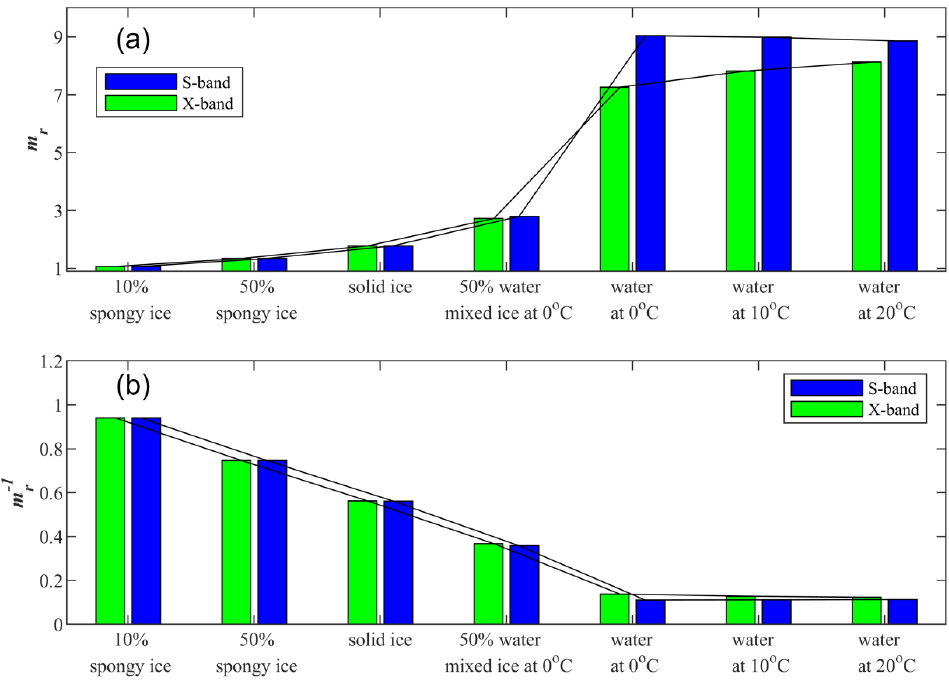
Figure 1. Dielectric property parameters: ( a ) m r and ( b ) m r − 1 of hydrometeors at different phases and temperatures